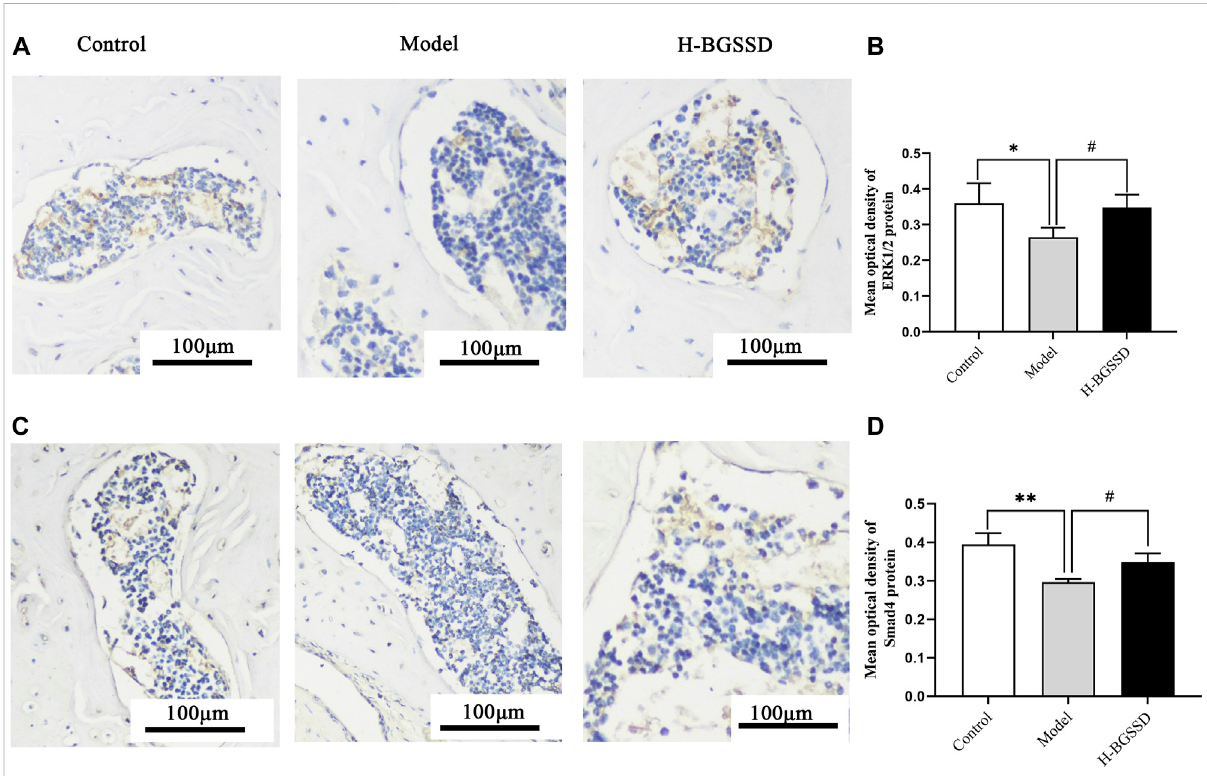
FIGURE 4 BGSSDenhanced theexpressionofERK1/2andSmad4proteins ofSAMP6. (A,C) Immunohistochemical stainingwascarried outtoevaluatethe expression of ERK1/2 and Smad4 protein. Scale bar = 100 µm. (B,D) The mean optical density of ERK1/2, Smad4 protein was quanti fi ed by ImageJ. Values were expressed as mean ± SD, * p < 0.05, ** p < 0.01, the model group versus the control group; # p < 0.05, the group of high-dose BGSSD versus the model group. All the assays were repeated more than three